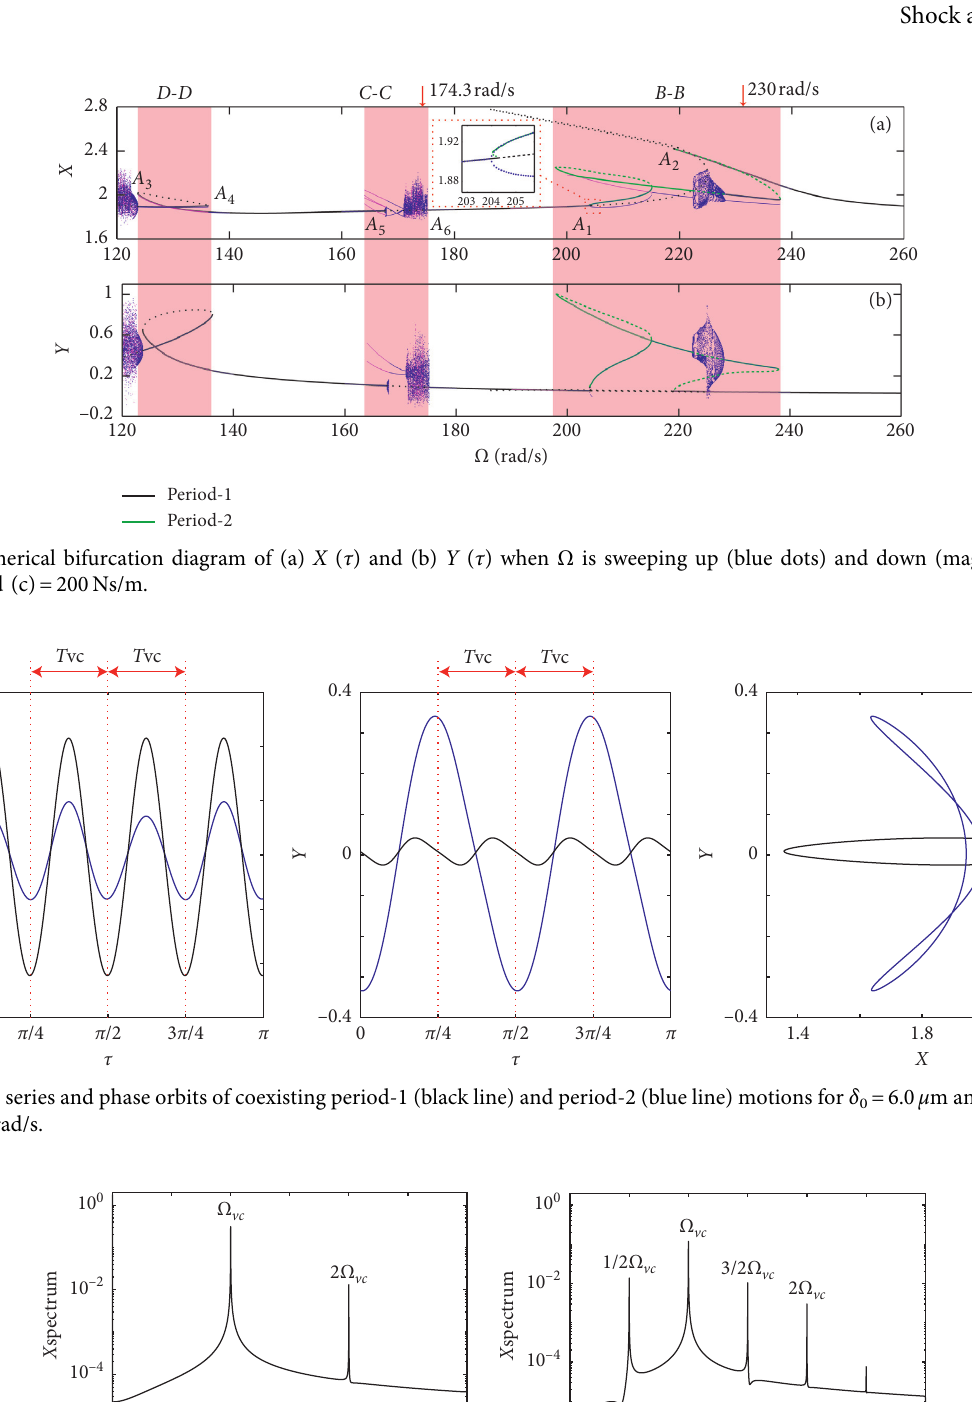
� 6.0 μ m and c � 200Ns/m when Ω � 0